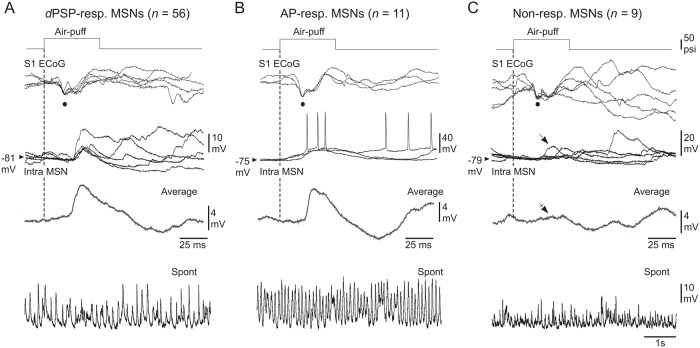
Characterization of somatosensory MSNs as a function of their responsiveness to a given whisker stimulation.(A–C) Air-puff stimuli of same intensity (optimal stimuli, top traces) induced an early negative deflection in the ECoG (black dots), associated with either subthreshold synaptic responses (A, dPSP-responding), suprathreshold synaptic responses (B, AP-responding) or a lack of synaptic response (C, Non-responding) in the simultaneously recorded MSNs (Intra MSN). Three to 5 five successive responses are superimposed. The vertical dashed lines mark the onset of whisker stimuli. The average traces (excluding firing responses) were computed from at least 20 trials. The oblique arrow in (C) indicates the occurrence of occasional temporally-matching sensory responses, which was largely curtailed after averaging of 40 successive trials (crossed arrow). The lowest records are segments of spontaneous activity recorded in the corresponding MSNs. Results shown in (A), (B) and (C) are from three distinct experiments.